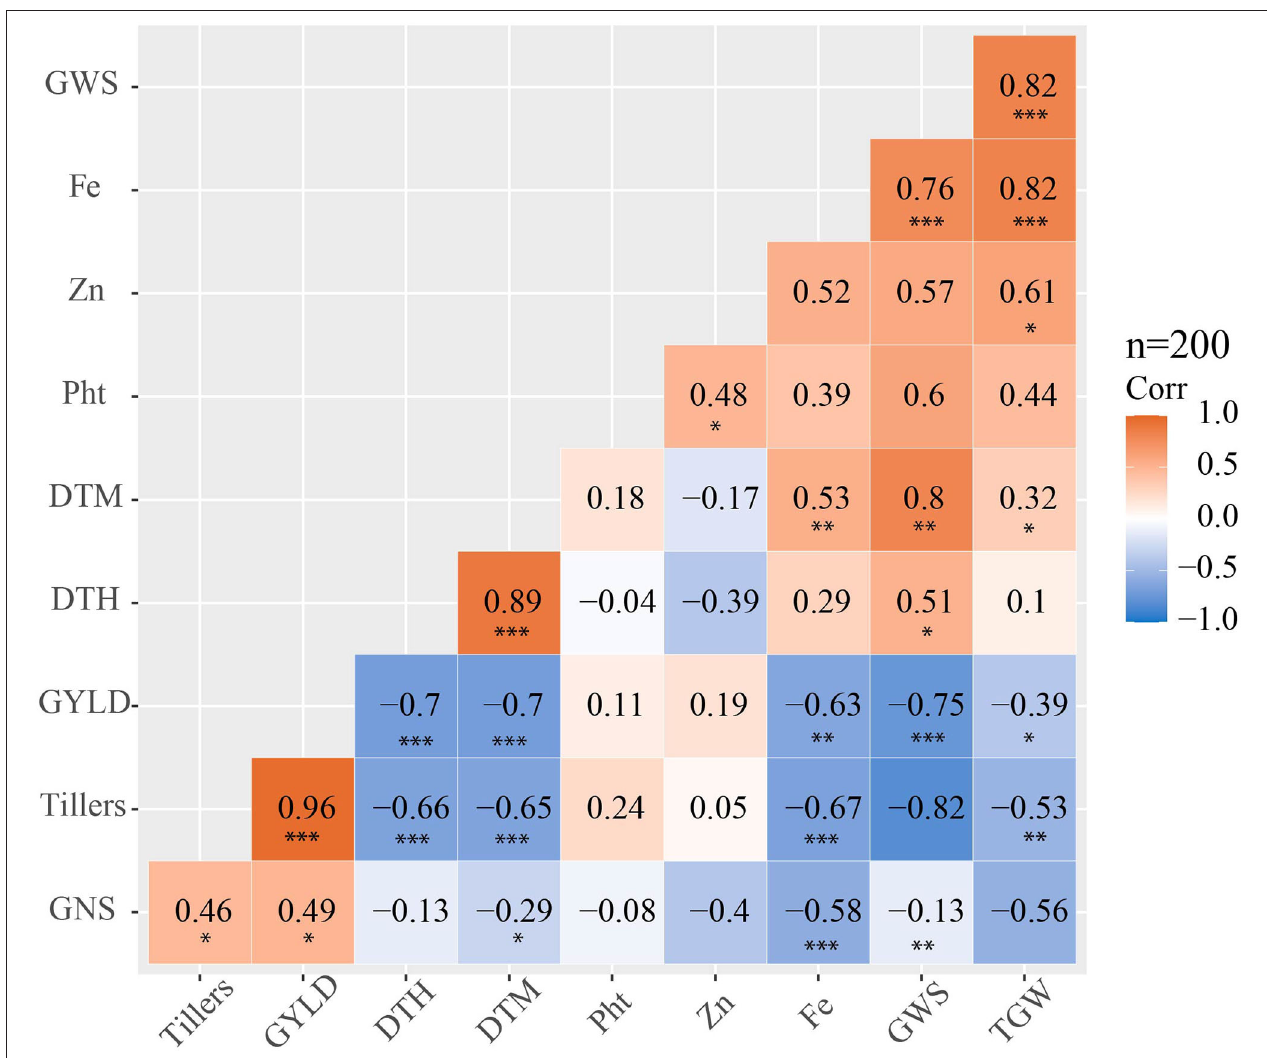
FIGURE 5 | Phenotypic correlation matrix showing phenotypic correlation coefficients among the studied traits for yield, yield-related traits and zinc, and iron concentration in the 6th, 7th, 8th and 9th HPYTs (DTH, days to heading; DTM, days to maturity; Pht, plant height; GWS, grain weight per spike; GNS, grain number per spike; GY, grain yield; Fe, grain iron concentration; Zn, grain zinc concentration); the significance levels are indicated below the correlation coefficient as *: p < 0.05, **: p < 0.01 and ***: p <